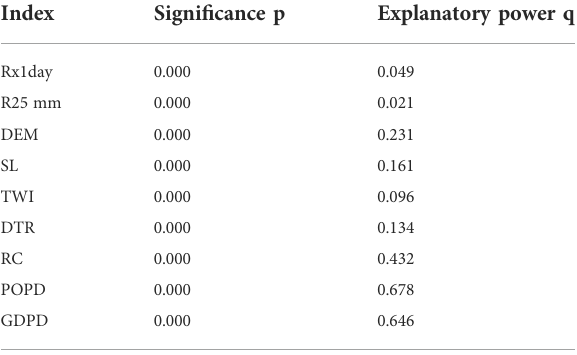
TABLE 5 Explanatory power of environmental